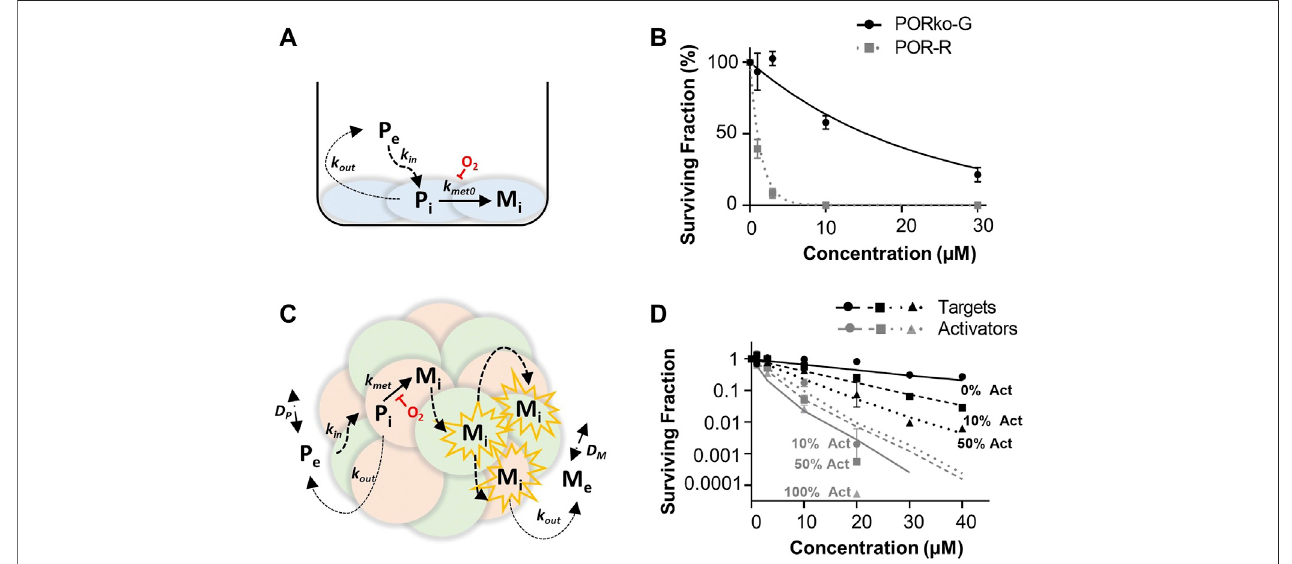
FIGURE7| ABMsimulationsofclonogeniccellsurvivalinmonolayerandspheroidculturesfollowingCP-506treatment. (A) Schematicrepresentationofthecellular uptake, metabolism and diffusion of CP-506 in monolayer cultures. Exchange of the extracellular prodrug (P e ) and intracellular prodrug (P i ) between cell membranes is de fi nedbypermeabilityrateconstantsk in andk out withmetabolismofP i tointracellularmetabolites(M i )de fi nedbythe fi rstorderrateconstantk met0 andisstrictlyoxygen- dependent. (B) Model predictions (lines) compared toexperimental determinations(symbols) of clonogenic survival in monolayer cultures of target (PORko-G) and activator (POR-R) cells exposed to CP-506 for 4 h under anoxic conditions ( < 1 ppm O 2 ) determined from the monolayer ABM by fi tting k d for POR-R cells and the k met0 parameter for PORko-G cells (data redrawn from Figure 2C ). (C) Schematic representation of the cellular uptake, metabolism and diffusion of CP-506 in spheroid co- cultures.Diffusionofextracellularprodrug(P e )andintracellularprodrug(P i )acrosscellmembranesisde fi nedbypermeabilityrateconstantsk in andk out .P i ismetabolized tointracellularmetabolites(M